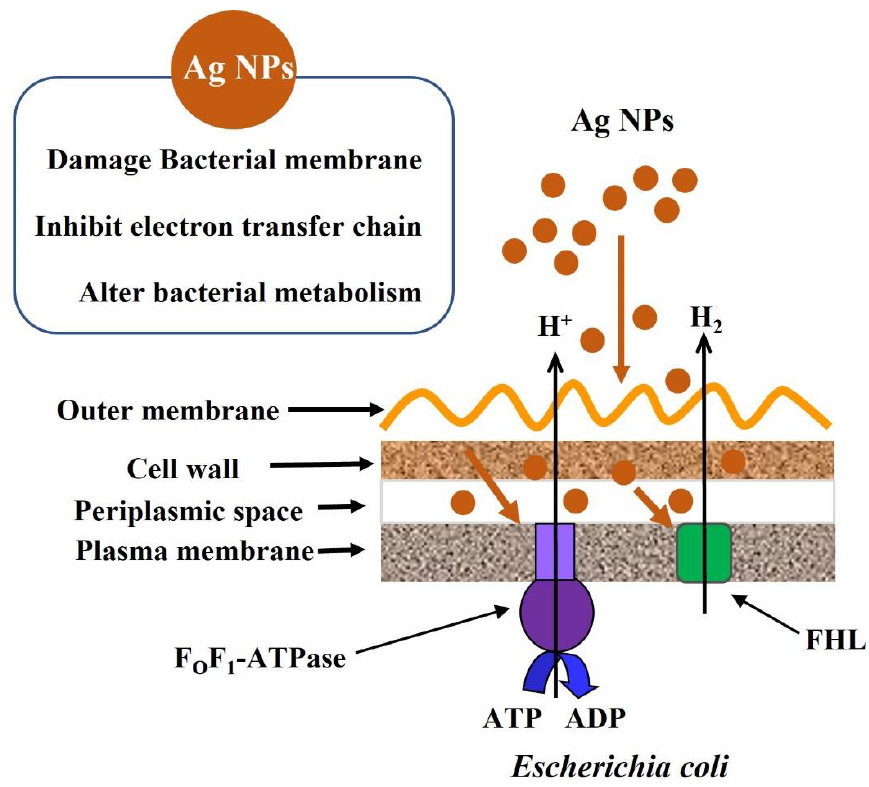
Figure 8. Schematic presentation of possible action mechanisms of Ag NPs on E. coli .